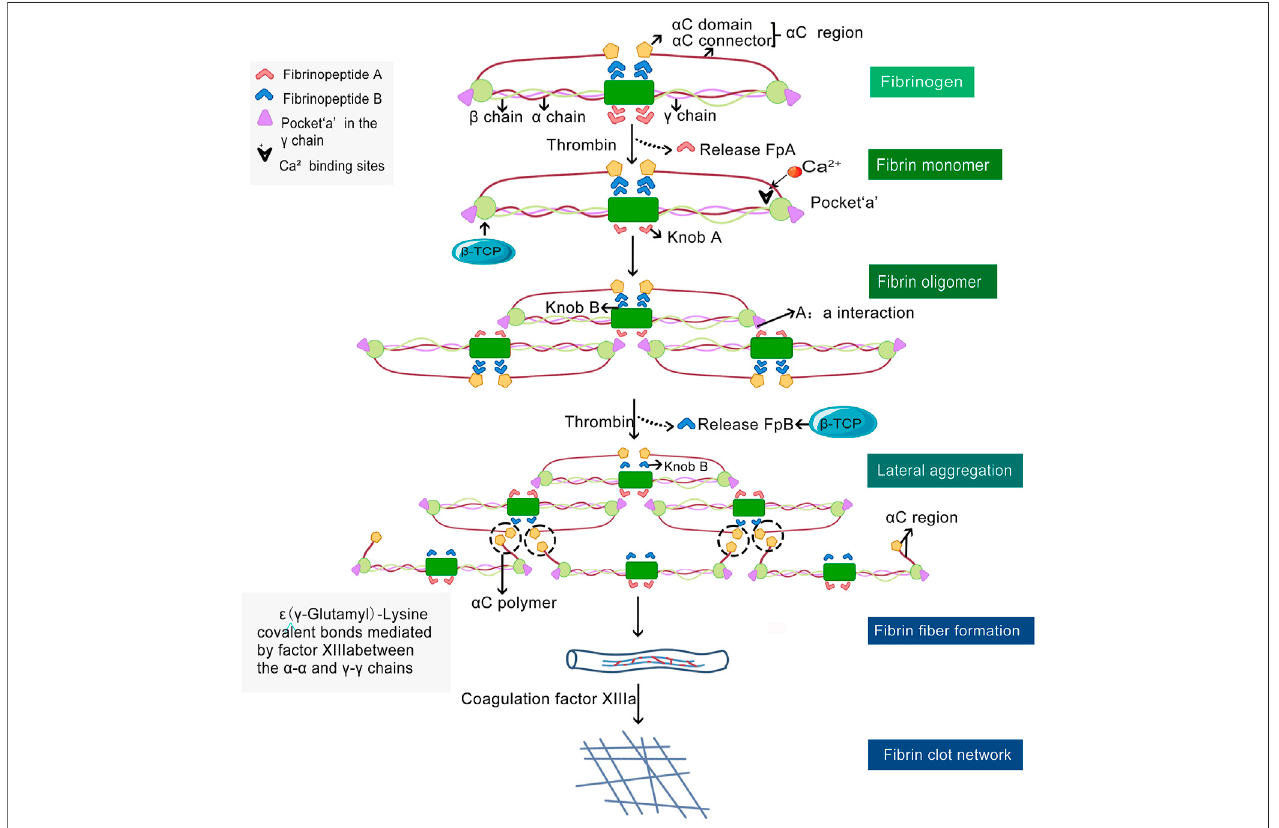
FIGURE 4 | Polymeric fi brin network formation and β -TCP regulatory sites. Thrombin mediates the of monomeric fi brinogen to polymeric fi brin by catalyzing the cleavage and release of fi brinopeptides (Fp)A (light red dovetail arrows) and FpB (blue dovetail arrows) from fi brinogen. Fibrin monomers originating from FpA aggregate longitudinally and form fi brin oligomers, which in turn polymerize to form proto fi brils. The proto fi brils undergo lateral polymerization via intermolecular interaction at α C regions to form α C polymers (black dashed circles) and results in the formation of thick fi bers. Finally, the fi brin clot, a cross-linked gel-like meshwork forms and plays animportantroleinnormal hemostasis. β -TCP mayregulate fi brinpolymerizationatthecleavage siteswhen FpBisreleased and attheprimarybindingsites(black arrow heads) of the fi brinogen γ chain (orange color).